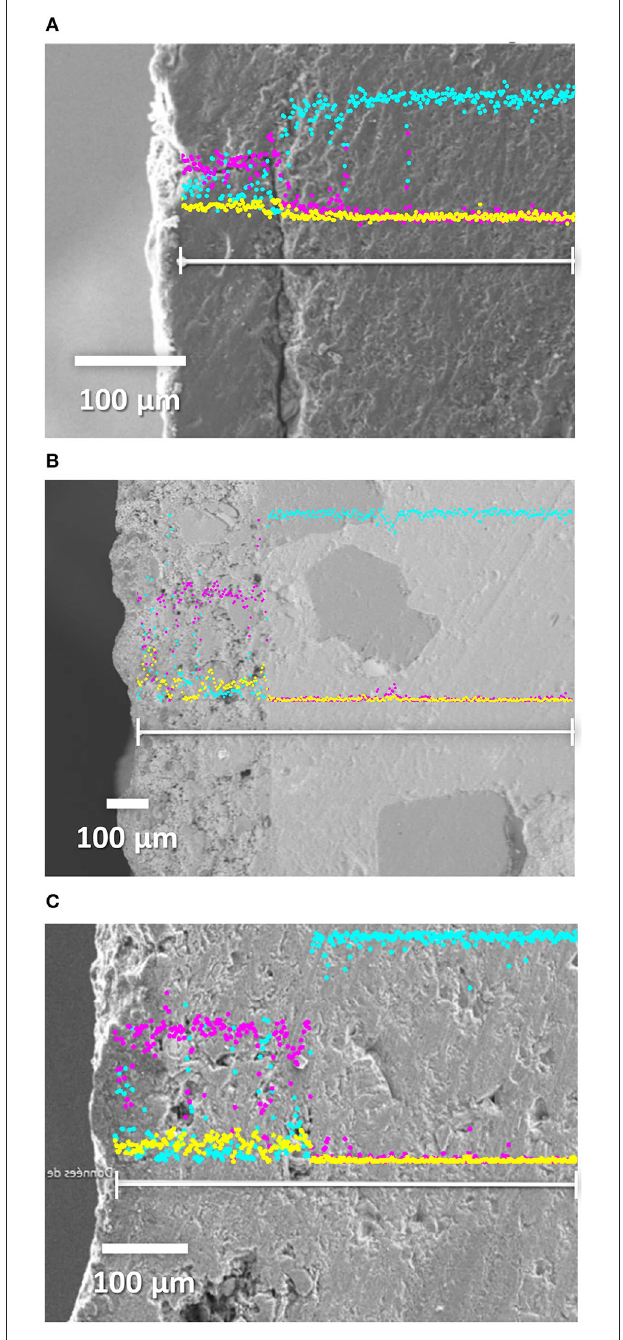
FIGURE 7 | SEM images and concentration profiles of Si (K α = 1,739 keV), K (K α = 3,312 keV), and Ca (K α = 3,690 keV) elements for the coating (A) SM1, (B) SA3M1Sb1, and (C) SA5M1Sb2, applied on Fez stone sample, with (purple = Si), (yellow = K), and (blue = Ca).